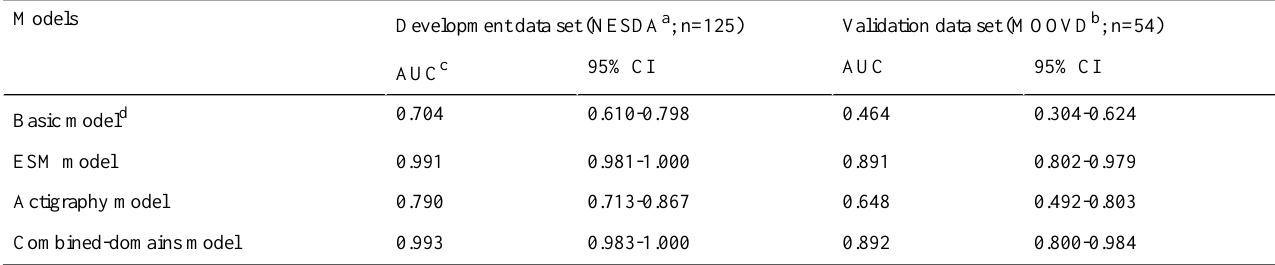
Table 3. The discriminative ability of the final combined-domains model and the basic, actigraphy, and experience sampling method (ESM) models.